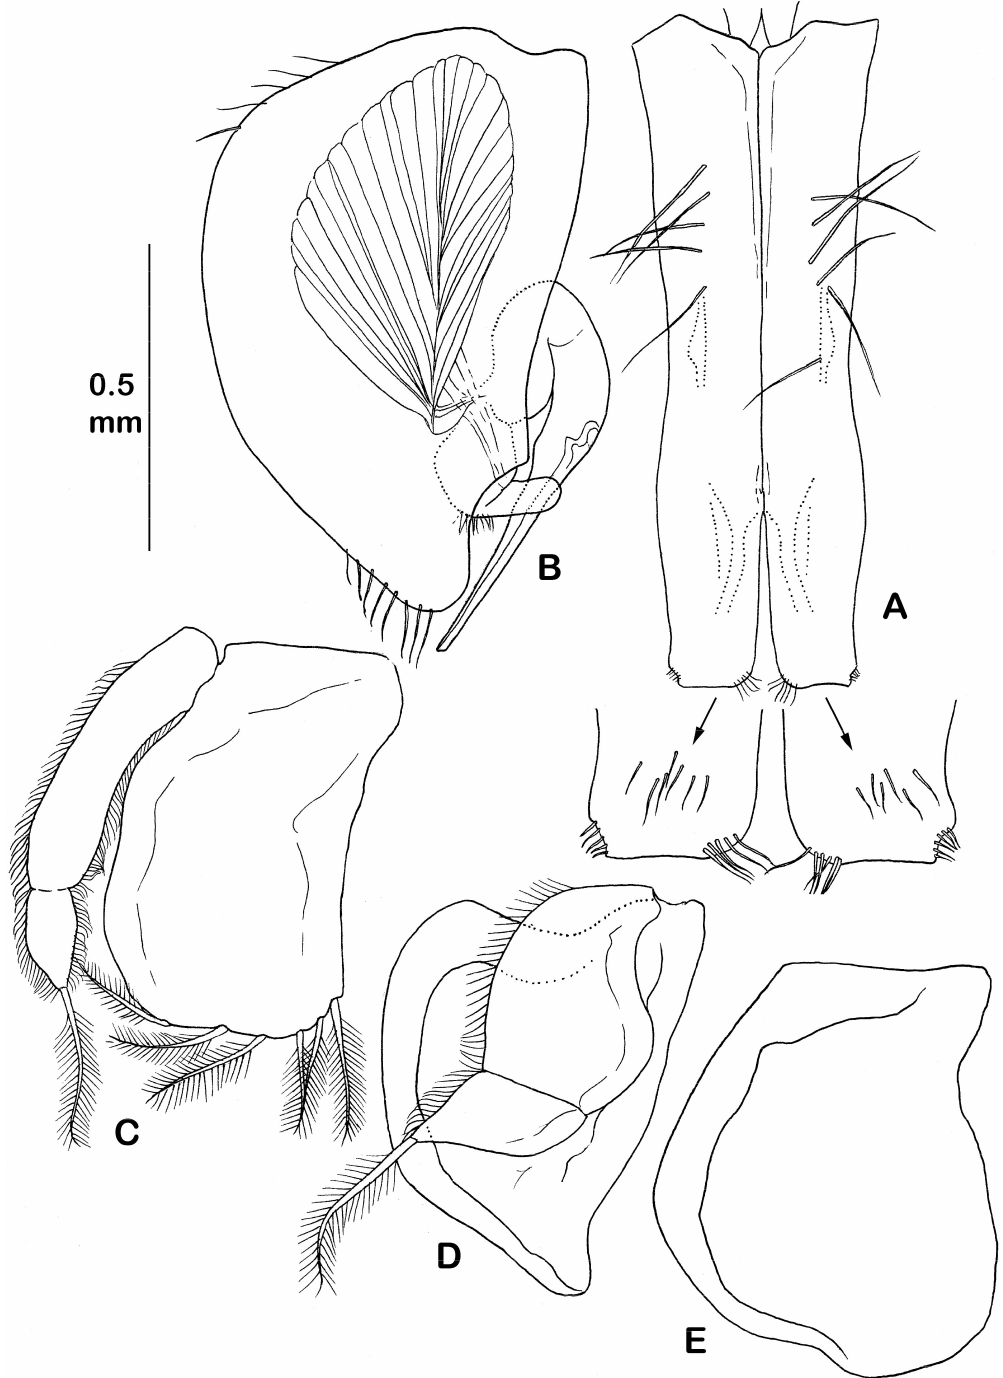
Figure 13. Eurycope dahli Svavarsson, 1987. Male (ZMH K-45609): ( A ) pleopod I (distal margin enlarged); ( B ) pleopod II; ( C ) pleopod III; ( D ) pleopod IV; ( E ) pleopod V. 3.4. Eurycope mishkai Malyutina & Schnurr sp. nov. http://zoobank.org/4EBD065A-900B-4F8B-99C1-F957C591FFB2 (accessed on 3 June 2022) Material examined: Holotype: male (ZMH K-45621), 3.1 mm